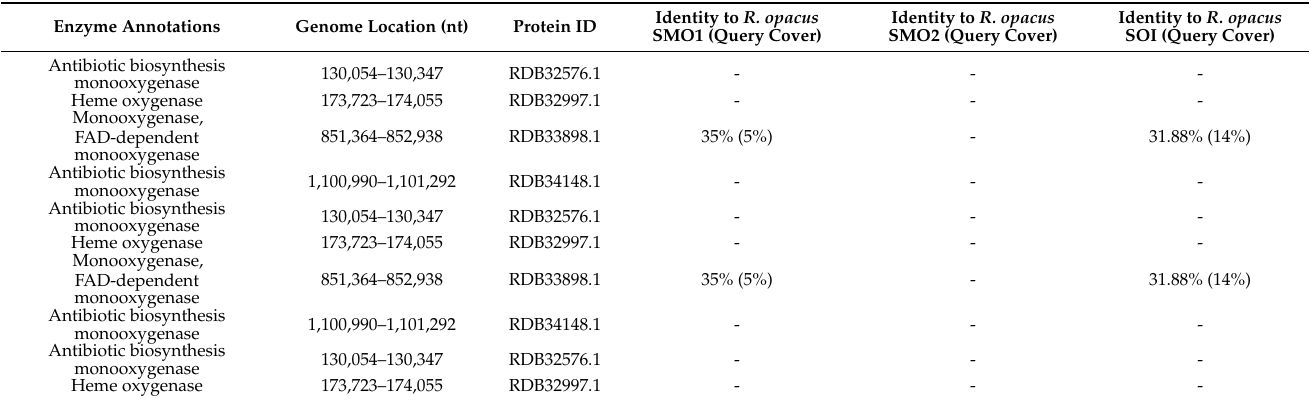
Table 1. Putative orphan proteins involved in PS degradation identified from searches of the genome annotations for Exiguobacterium sp. RIT 594. Comparisons of RIT 594 proteins with proteins attributed to styrene degradation in previously characterized Rhodococcus opacus [13], -styrene monooxygenases (SMO1 and SMO2), and styrene oxide isomerase (SOI).